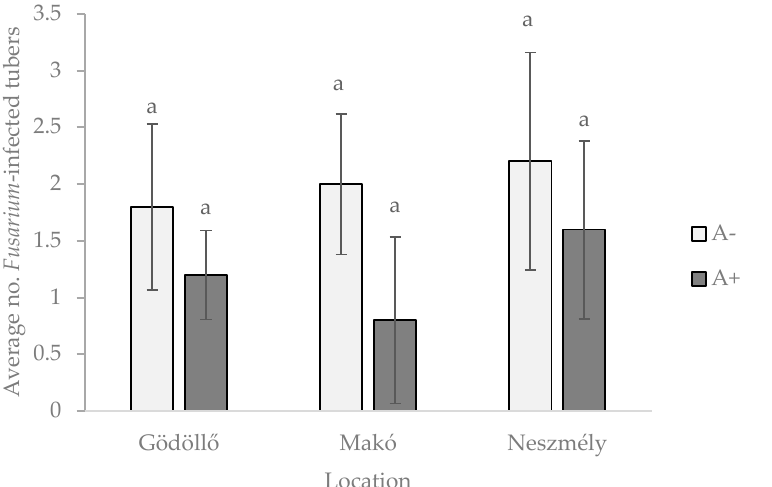
Figure 13. Effect of the presence of Armadillidium vulgare (A+) on the number of infected tubers in three locations (Gödöll ő , Makó, Neszmély) in 2018 as confirmed by a microscopic evaluation. Different letters above the bars indicate a significant ( p ≤ 0.05) difference between two treatments according to ANOVA and Tukey’s pairwise comparisons; error bar: CI 95%.